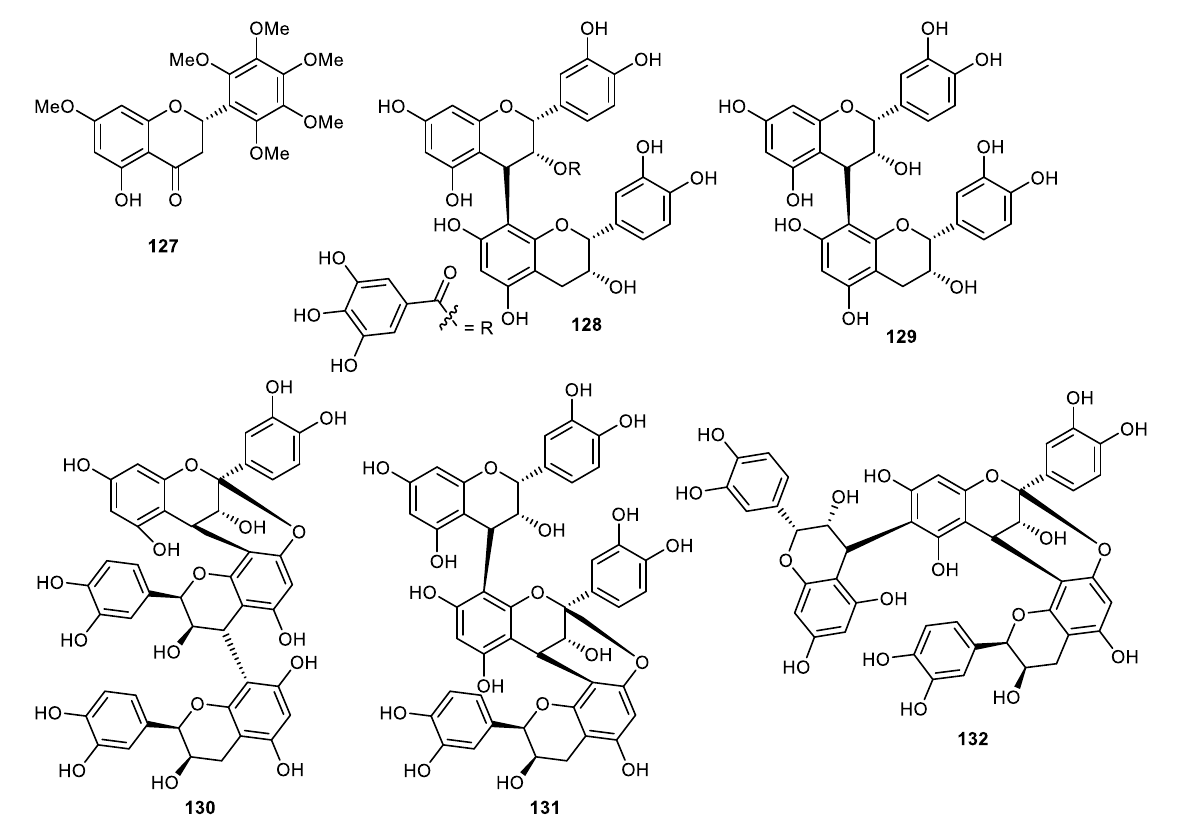
Figure 15. Structures of flavonoids 127 – 132 .